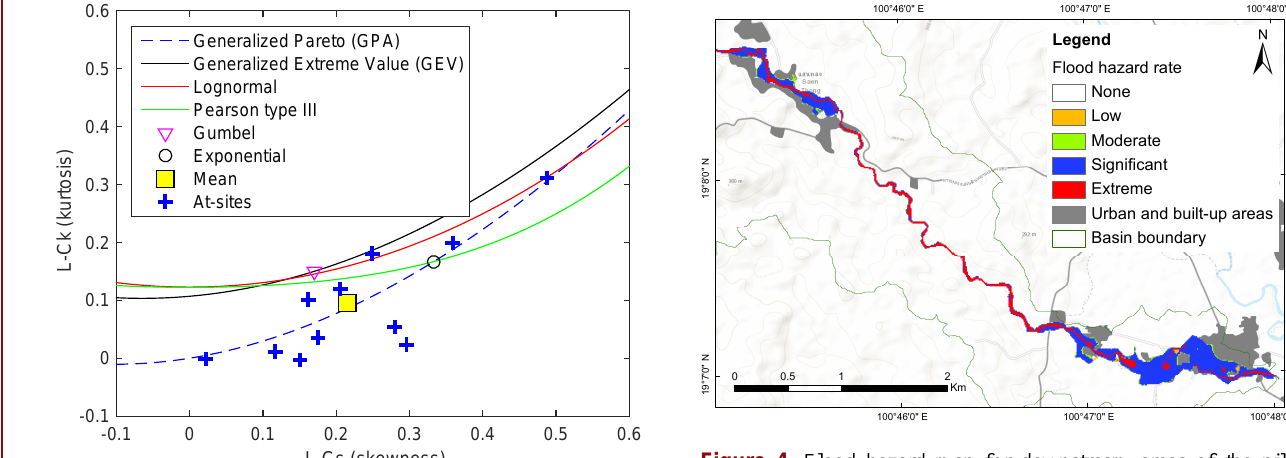
Figure 4. Flood hazard map for downstream areas of the pilot catchment based on the scenario of